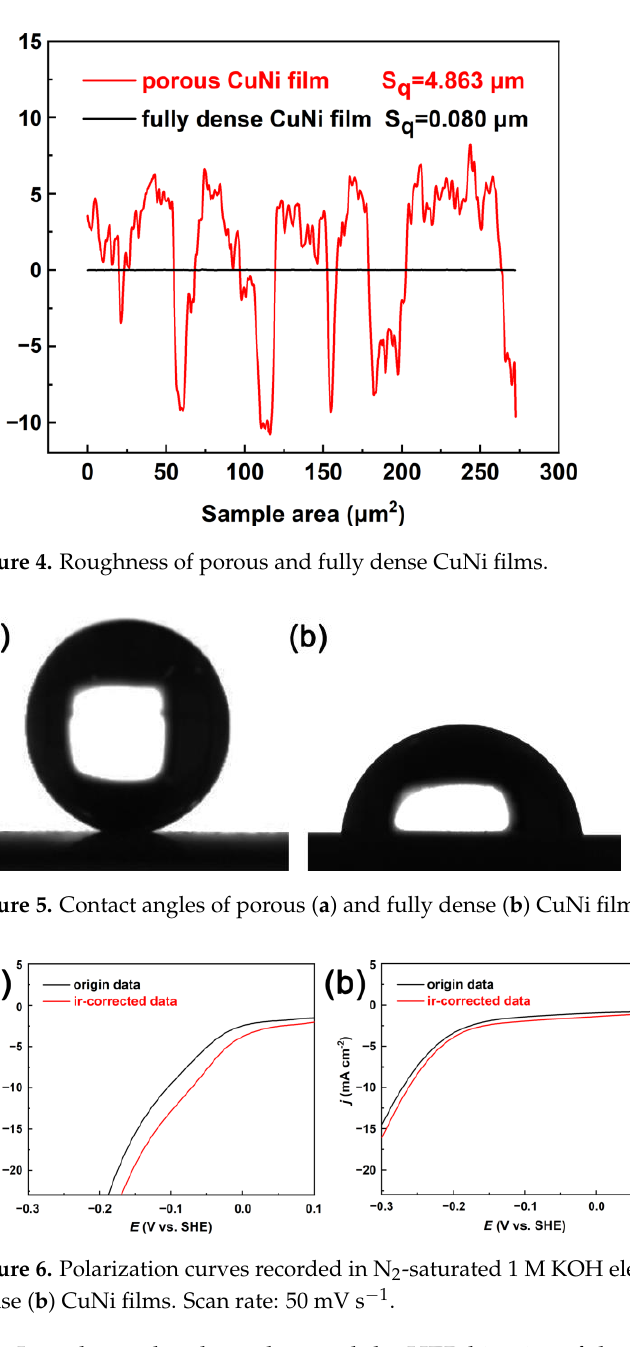
Figure 4. Roughness of porous and fully dense CuNi films.